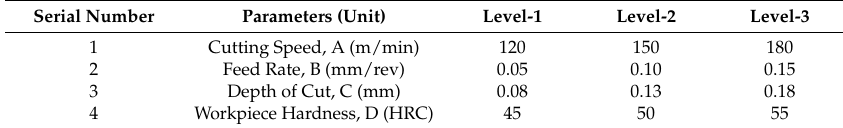
Table 4. Design Matrix and